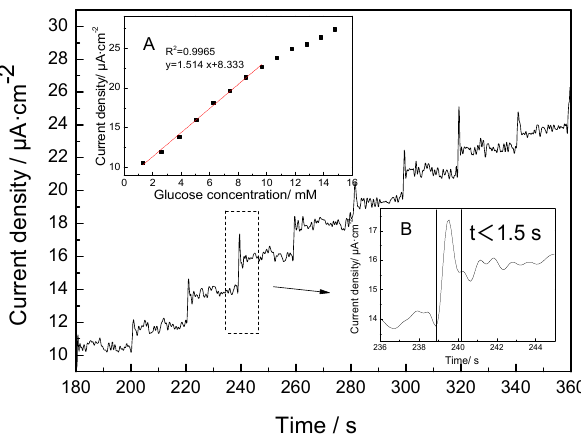
Figure 8. Current–time responses of the GOx / HTNTs / Ti electrode to the successive addition of glucose in PBS (pH = 7.4) under an applied potential of 0.55 V (vs. Saturated Calomel Electrode, SCE); inserted graph A showed the corresponding linear calibration curve of the GOx / HTNTs / TiO 2 electrode as a function of glucose concentration and inserted graph B was a magnifying diagram of the dotted line square frame.